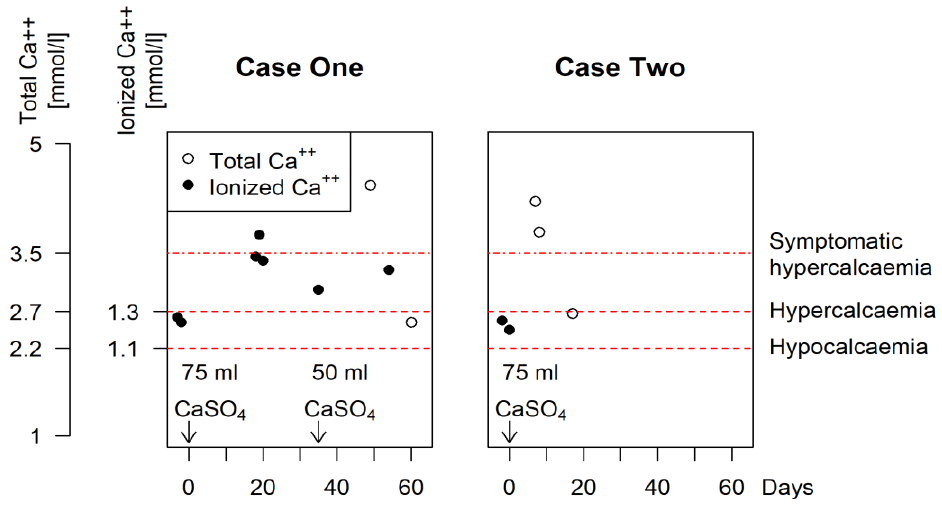
Figure 1. Perioperative calcium blood level measurements of the two cases affected by symptomatic hypercalcaemia. Black dots indicate the ionized calcium obtained with blood gas analysis. Considering the influence of pH on the levels of ionized calcium, this allows only a crude identification of hypo- and hypercalcemia. In Case One, we see ionized calcium levels high above the commonly admitted symptomatic level, but the patient presented no symptoms at that time. The white dots show the values of albumin-corrected total calcium levels. A line marks the usually accepted threshold for severe symptomatic hypercalcemia of 3.5 mmol/L. The CaSO 4 dose is noted in ml, as defined by the manufacturer of the product used (Osteoset, Wright Medical, Memphis, TN, USA). In Case One, vancomycin-loaded calcium sulphate beads (CaSO 4 ) had been implanted two times during a staged procedure. Case Two was a single-stage revision with debridement and exchange of the modular components.